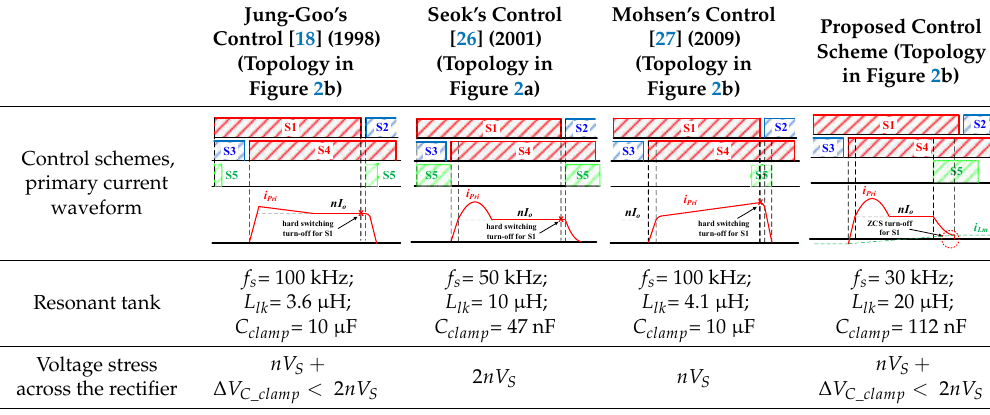
(2001) (Topology in